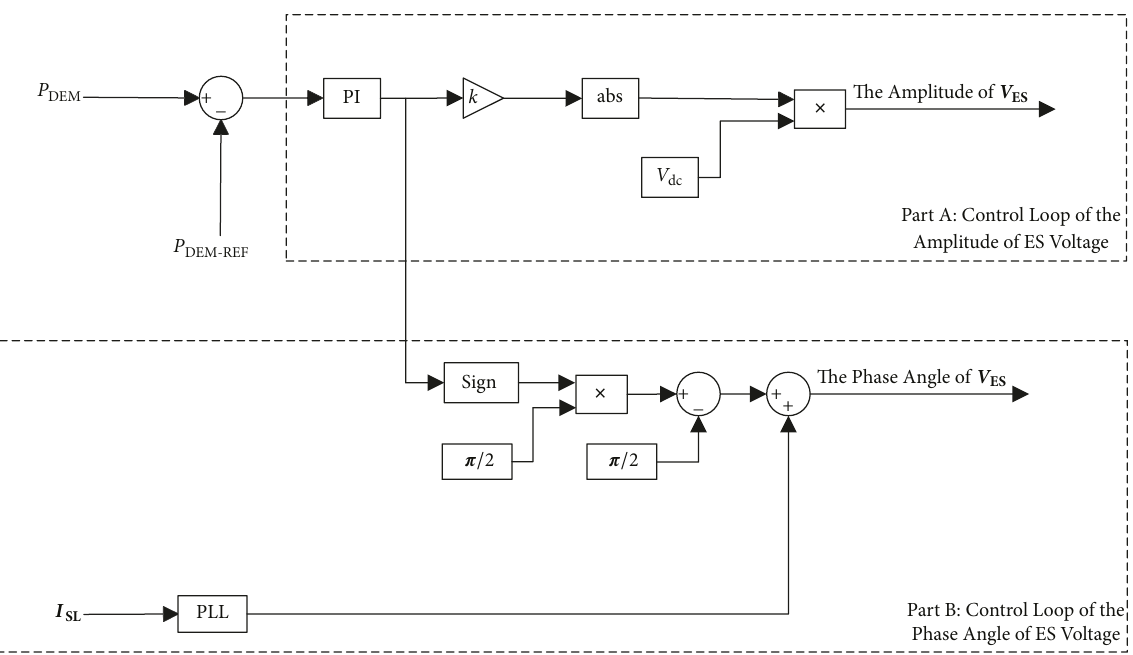
Figure 8: The control loop of ES